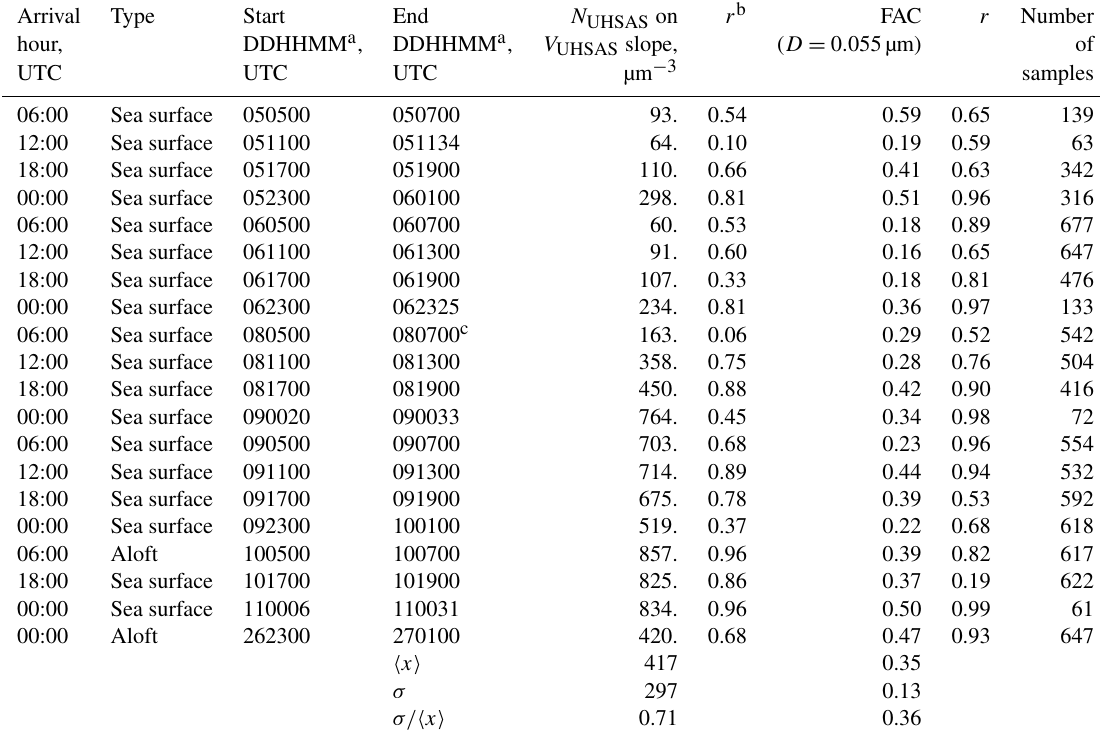
Table 3. Statistics for onshore trajectories (particle diameter integration in Eqs. 2, 4, and 5 is from 0.055 to